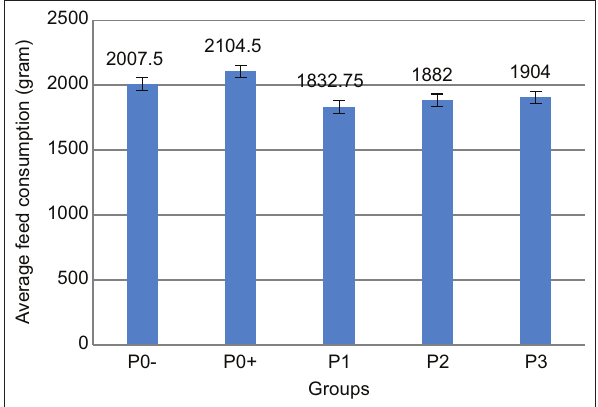
Figure-4: Average feed consumption in broiler chicken infected with Salmonella pullorum and administered with Meniran extract. P0-= Negative control treatment, P0+= Positive control treatment, P1= Treatment 1 (Group that was administrated with Meniran extract at 5% concentration), P2= Treatment 2 (Group that was administrated with Meniran extract at 10% concentration), P3= Treatment 3 (Group that was administrated with Meniran extract at 20% concentration). The administration of Meniran extract shows a decrease in feed consumption of broiler chickens infected with Salmonella pullorum than in control groups .